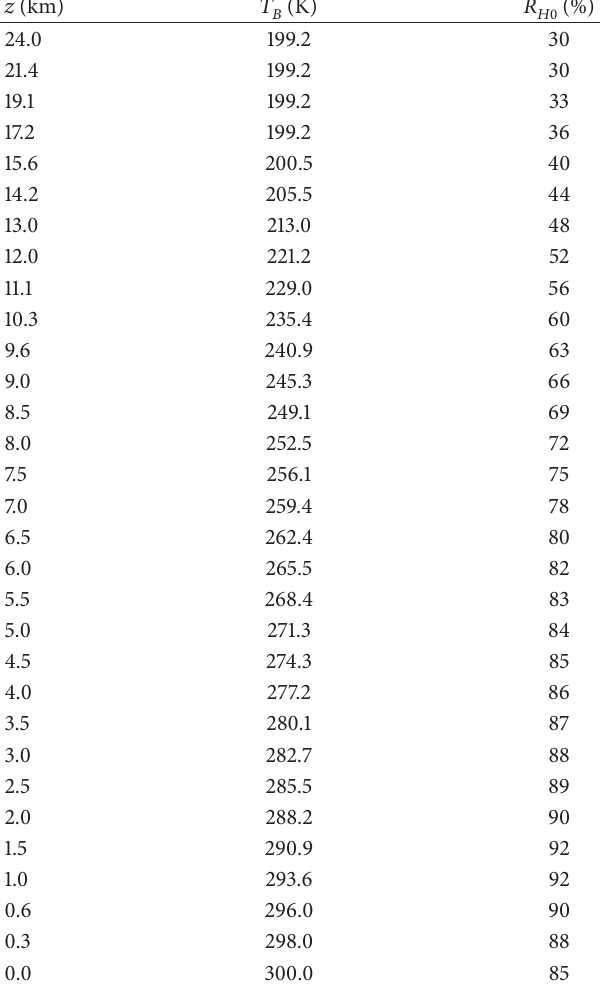
Table 1: The heights of the levels where the vertical velocity is predicted for a 30-layer model, the environmental temperature 𝑇 𝐵 , and the initial relative humidity 𝑅 𝐻0 at the center of the moist area ( 𝑥 = 0, 𝑦 = −100 km) are also shown.